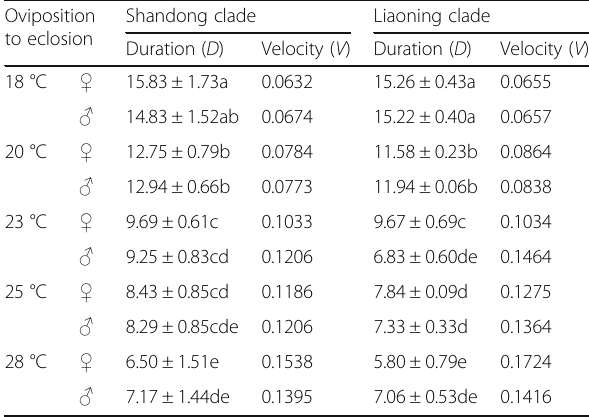
Table 1 Oviposition to eclosion durations of the non- overwintering generation of Aphelinus mali for two genetic clades in China